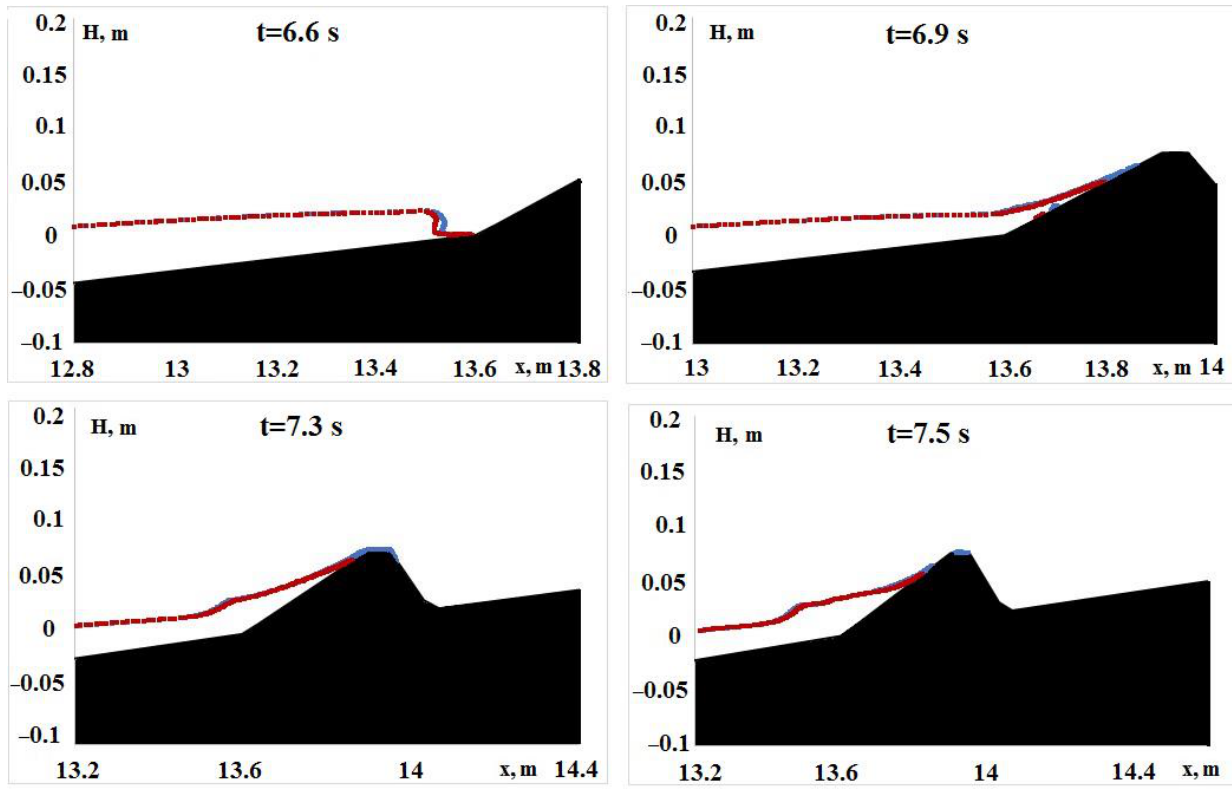
Figure 3. Comparison of the wave profiles for setup 1 ( —without TM, —with TM).